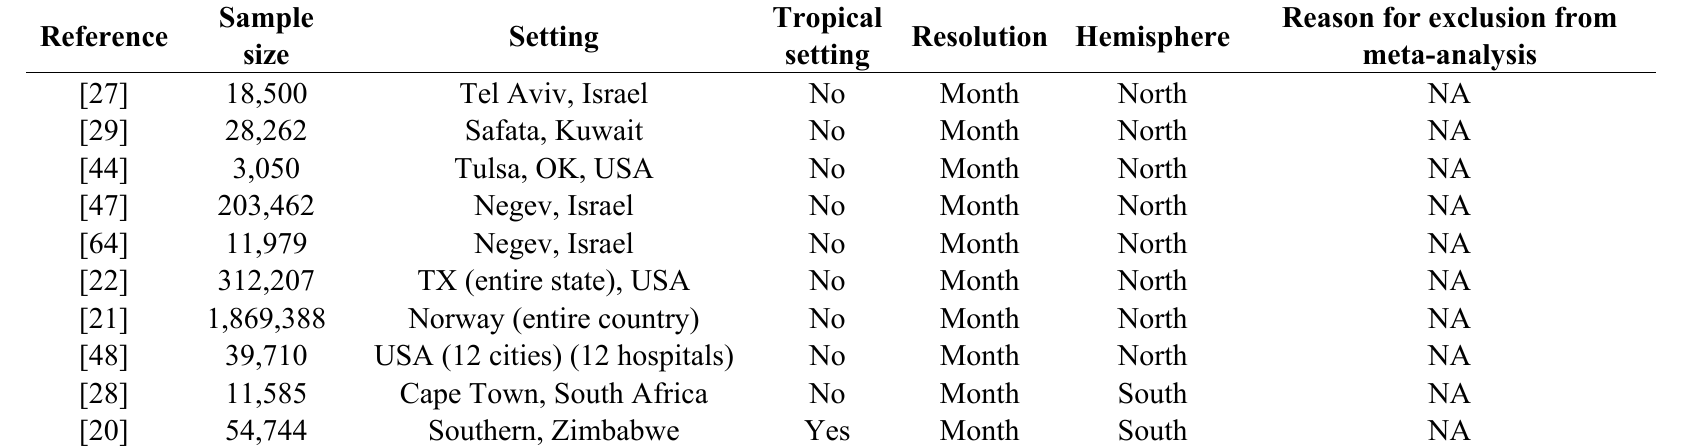
Table A3. Studies examined for the meta analysis of the influence of month of birth on preeclampsia incidence.